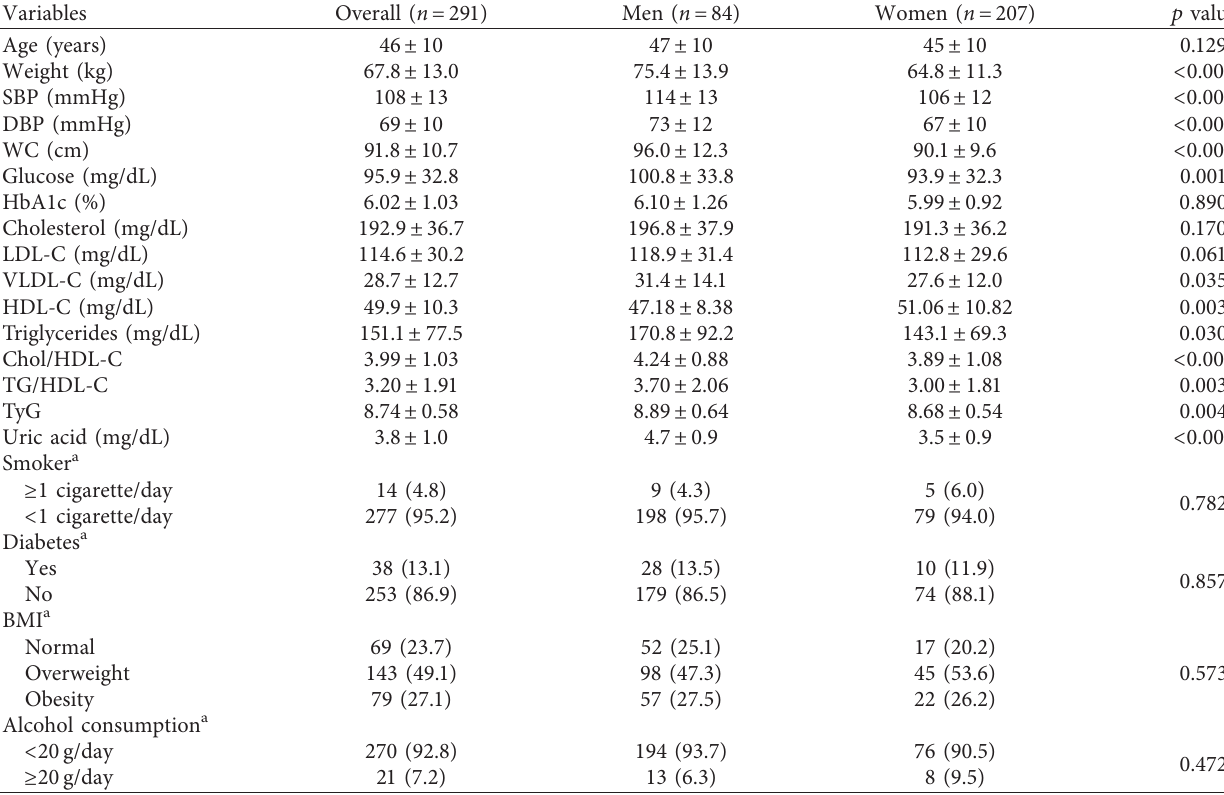
Table 1: General characteristics of participants by sex.